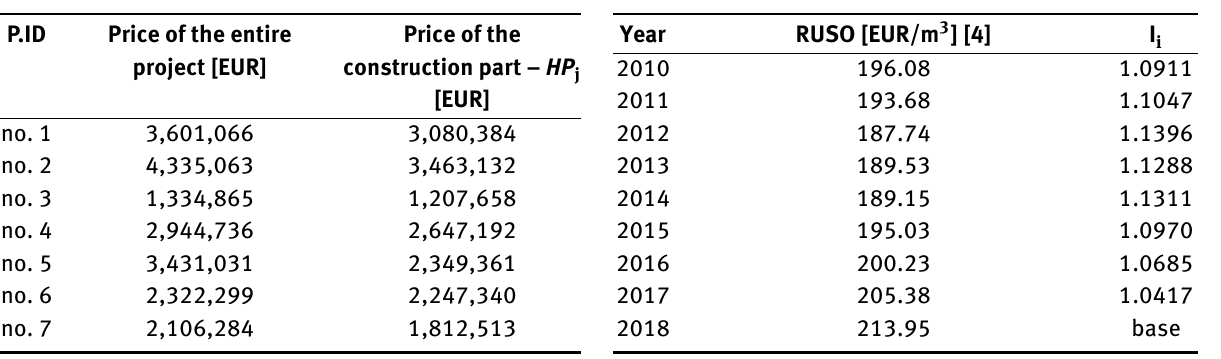
Table 2: Price input data [17]. Table 3: Price change index